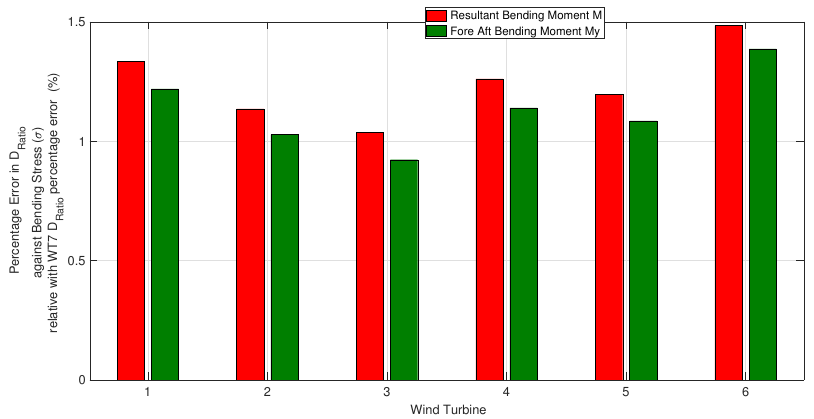
Figure 24. Percentage difference in normalised D ratio between resultant bending moment M and fore-aft bending moment M y and bending stress σ , for a range of wind